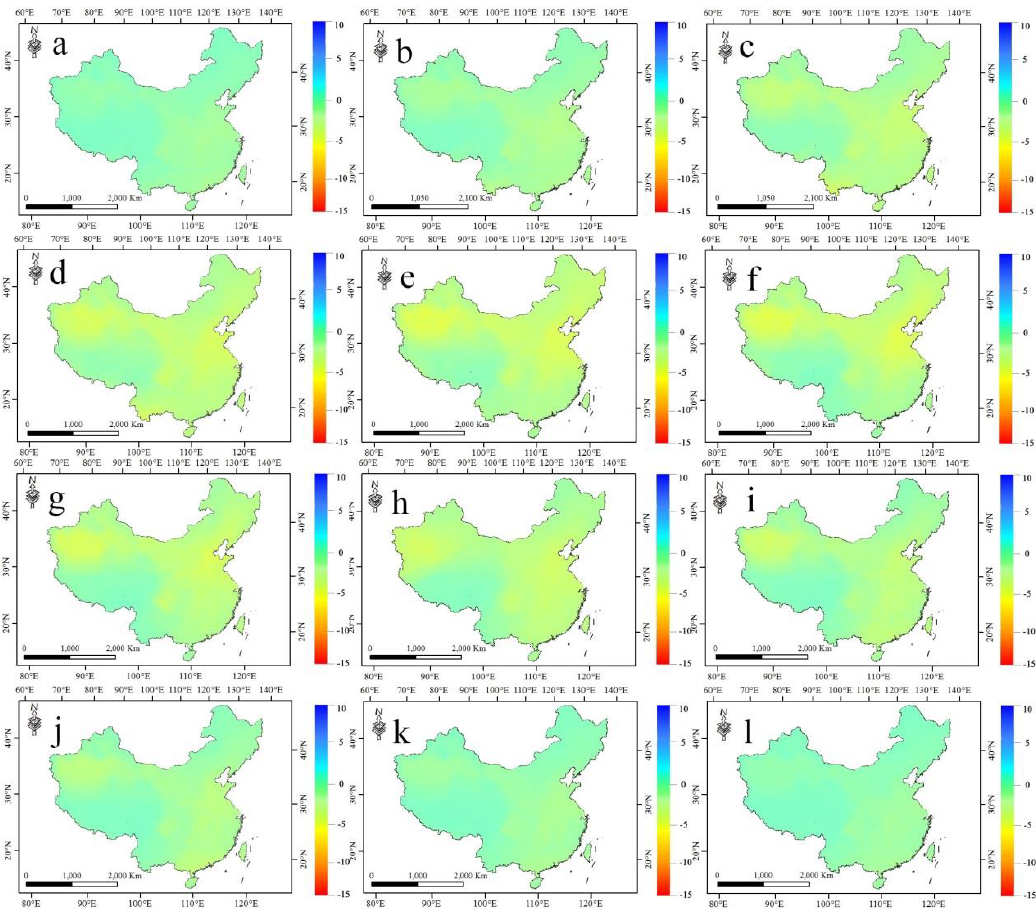
Figure.20. The monthly mean ARFB values throughout China (a for January, b for February, c for 525 Figure 20. Distribution of the monthly mean ARFB values throughout China during 1980–2015: ( a ) January; ( b ) February; ( c ) March; ( d ) April; ( e ) May; ( f ) June; ( g ) July; ( h ) August; ( i ) September; March, d for April, e for May, f for June, g for July, h for August, i for September, j for October, k for 526 ( j ) October; ( k ) November; and ( l ) Figure.19 and Figure.20 illustrated the spatial and temporal variation of ARFB over mainland 528